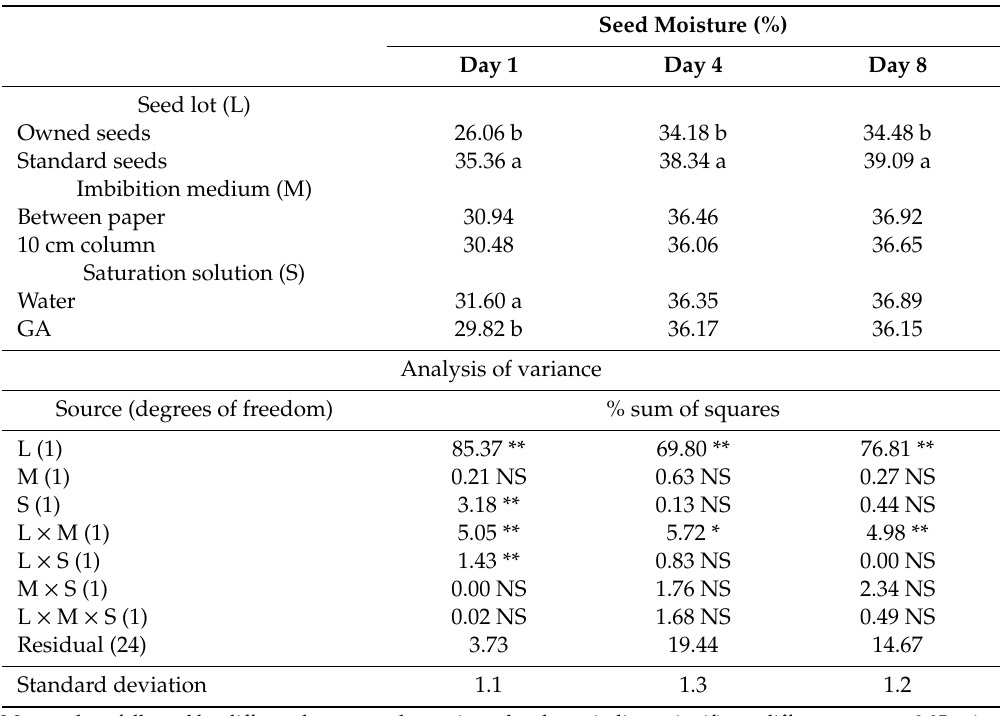
Table 5. E ff ects of the seed lot and imbibition medium, and solution on the seed water content (%) after 1, 4, and 8 days of soaking. Mean values.